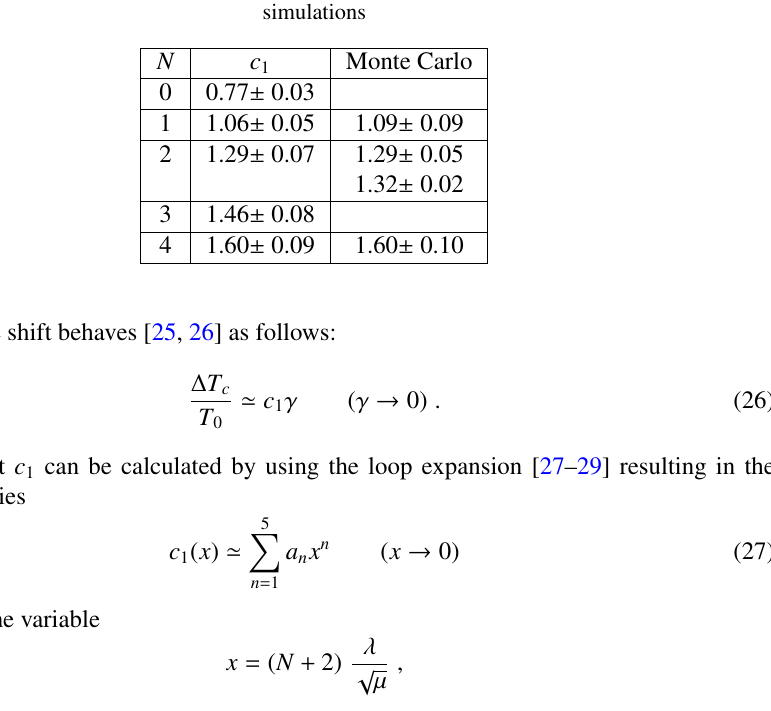
Table 1. The coe ffi cient c 1 of the critical temperature shift, for a di ff erent number of the field components N , given by self-similar factor approximants, compared with the available Monte